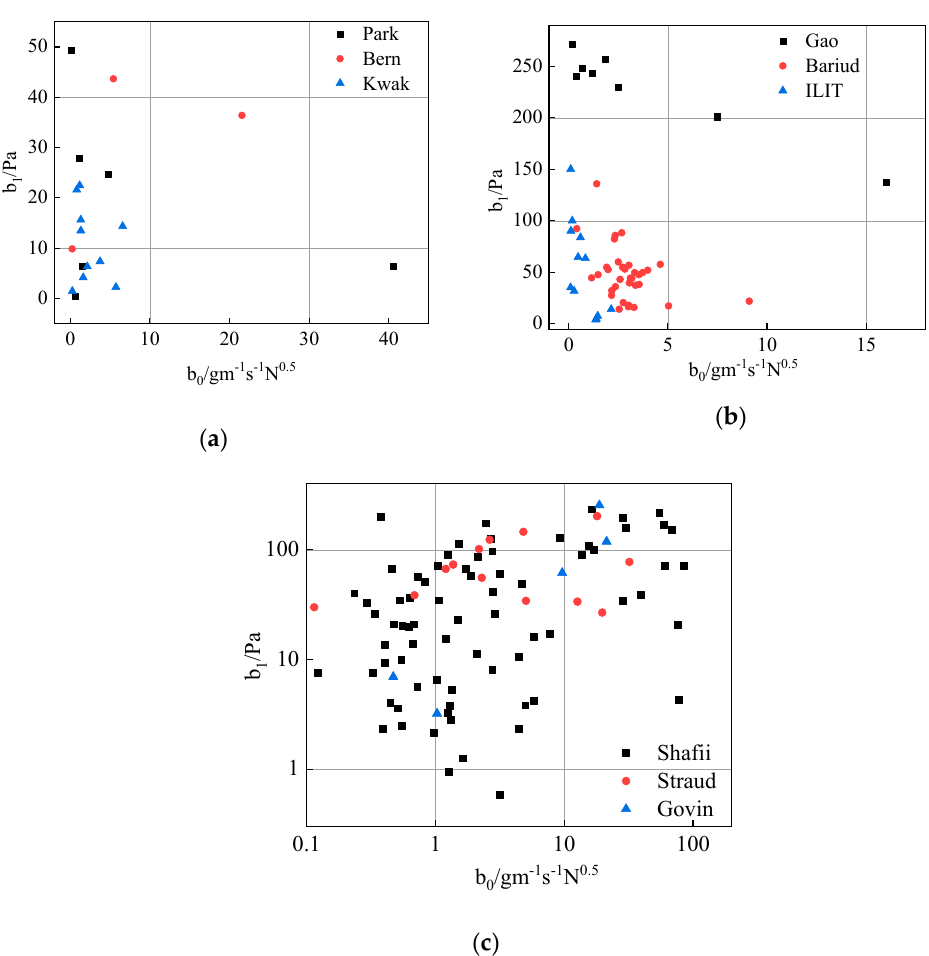
Figure 7. The erodibility parameter b 1 as a function of the erodibility b 0 under identical experimental conditions: Sub-dataset 1 ( a ), Sub-dataset 2 ( b ), and Sub-dataset 3 ( c ).